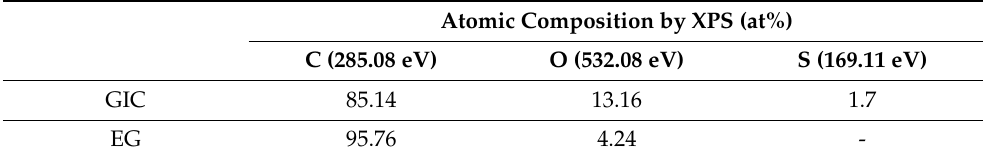
Table 3. Atomic composition by XPS analysis of EG and